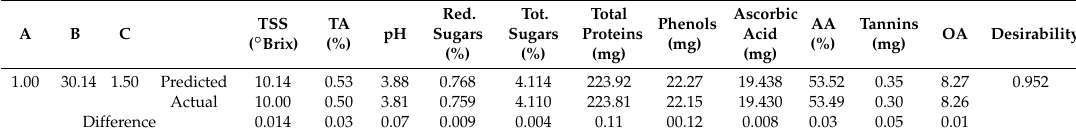
Table 3. Software generated optimum conditions for preparation of blended cucumber juice along with its predicted and experimental values for the best blend and phytochemicals.